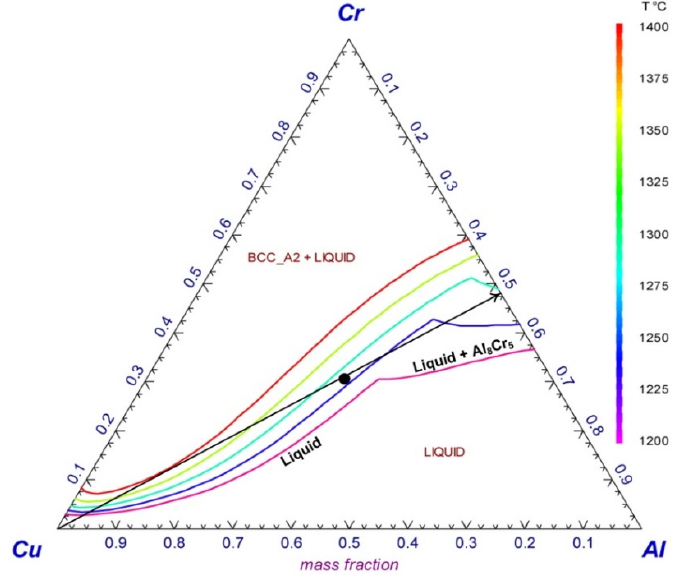
Figure 7. Cr-Al-Cu liquidus projection calculated in FactSage 7.3 [32].